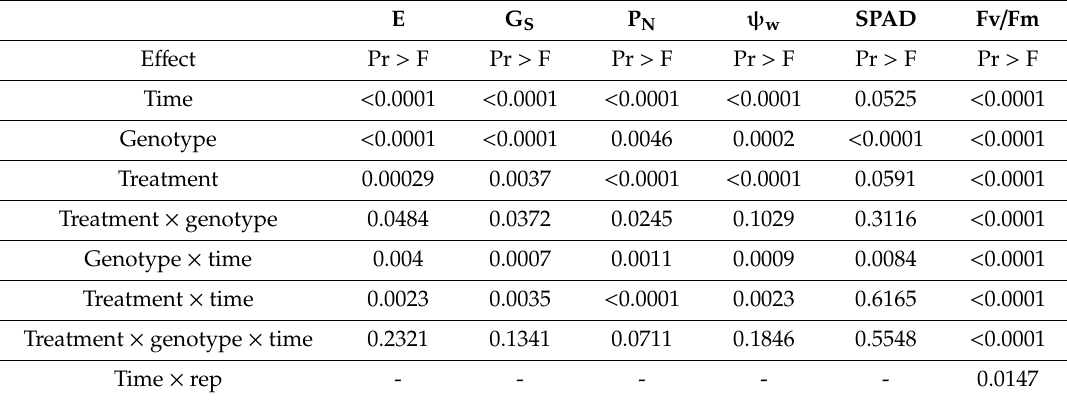
Table 1. There were significant interaction e ff ects between time, genotype and treatment for all traits. The three-way interactions were significant for Fv / Fm only. No interactions between genotype and treatment were found for P N , ψ w , and SPAD. Table 1. Summary of linear mixed model analysis of e ff ects of water treatment and time on measured parameters over the entire experimental period. Significant F-tests are shown in bold ( p < 0.05). E: transpiration rate; G S : stomatal conductance; P N : net photosynthesis rate; ψ w : leaf water potential;